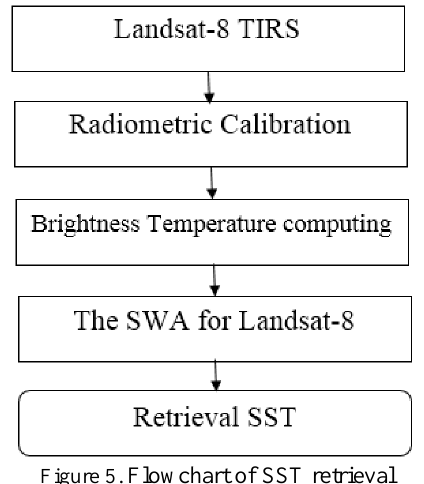
Figure 5. Flowchart of SST retrieval